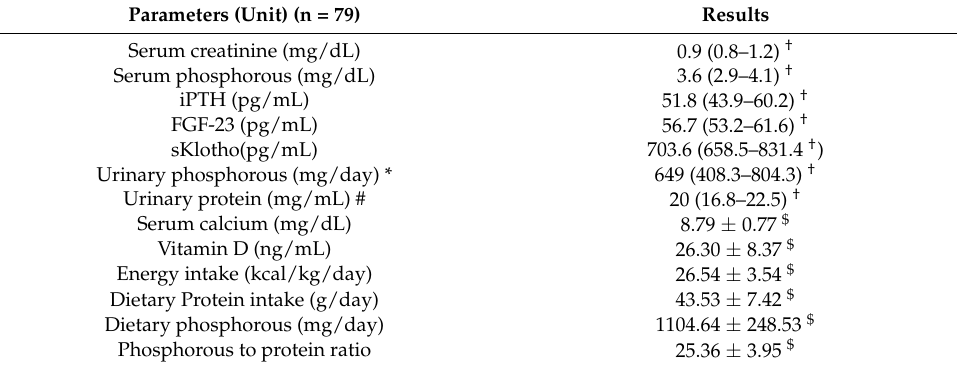
Table 3. Biochemical and dietary data of CKD patients (n =